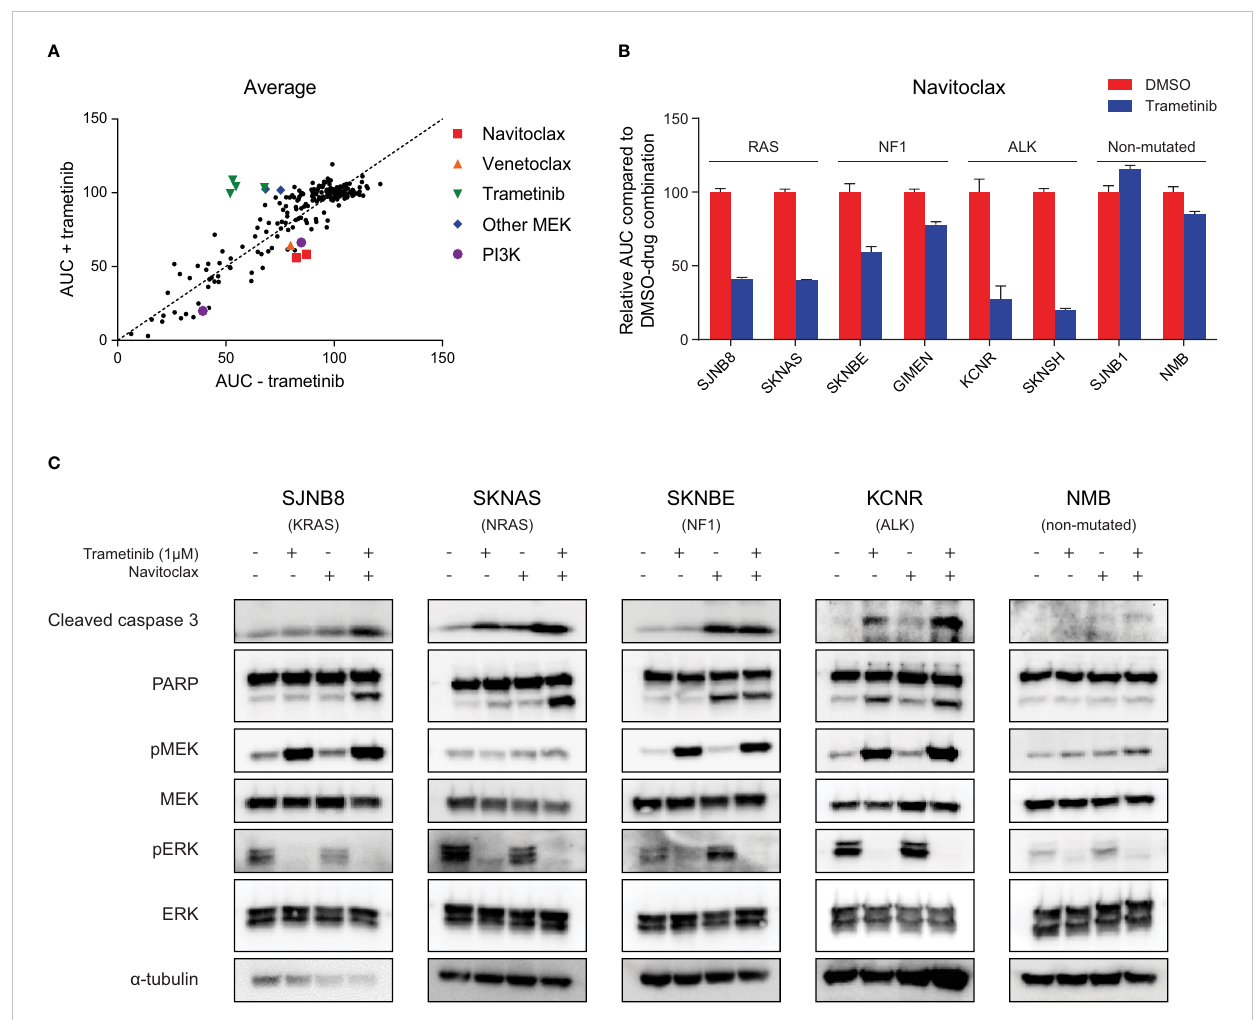
FIGURE 1 High throughput compound screening identi fi es navitoclax as a combination target with trametinib in neuroblastoma with RAS-MAPK mutations. (A) Relative area under the curve (AUC) for each screened compound in the presence of DMSO or trametinib averaged over four neuroblastoma cell lines (SJNB8, SKNAS, SKNBE, KCNR). (B) AUC for an extended panel of cell lines treated with seven concentrations of navitoclax combined with DMSO or trametinib. The AUC was normalized to the AUC of cells treated with navitoclax and DMSO. (C) Western blots of cell lines treated with DMSO, trametinib, navitoclax or the combination for 48